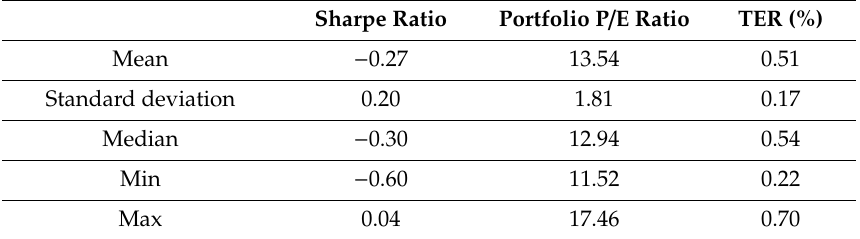
Table 2. Descriptive statistics of utility exchange traded funds (ETFs) data used in the